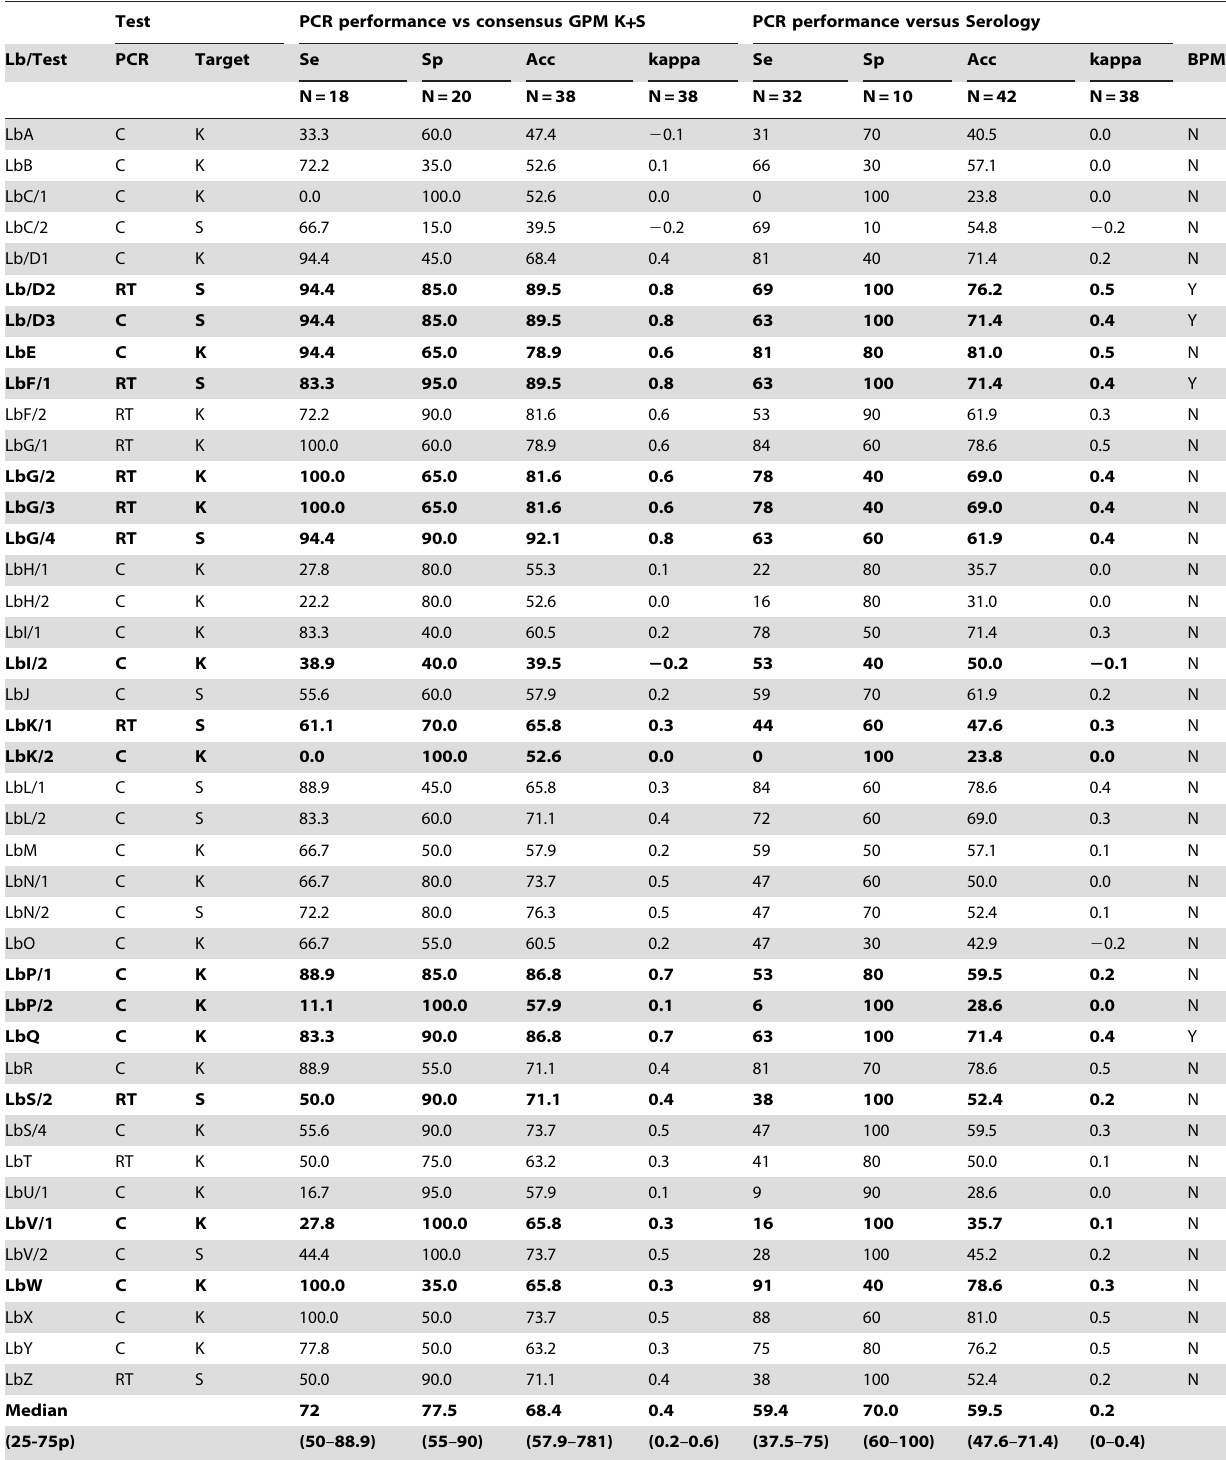
Table 4. Performance of PCR tests in comparison to consensus GPM reports and